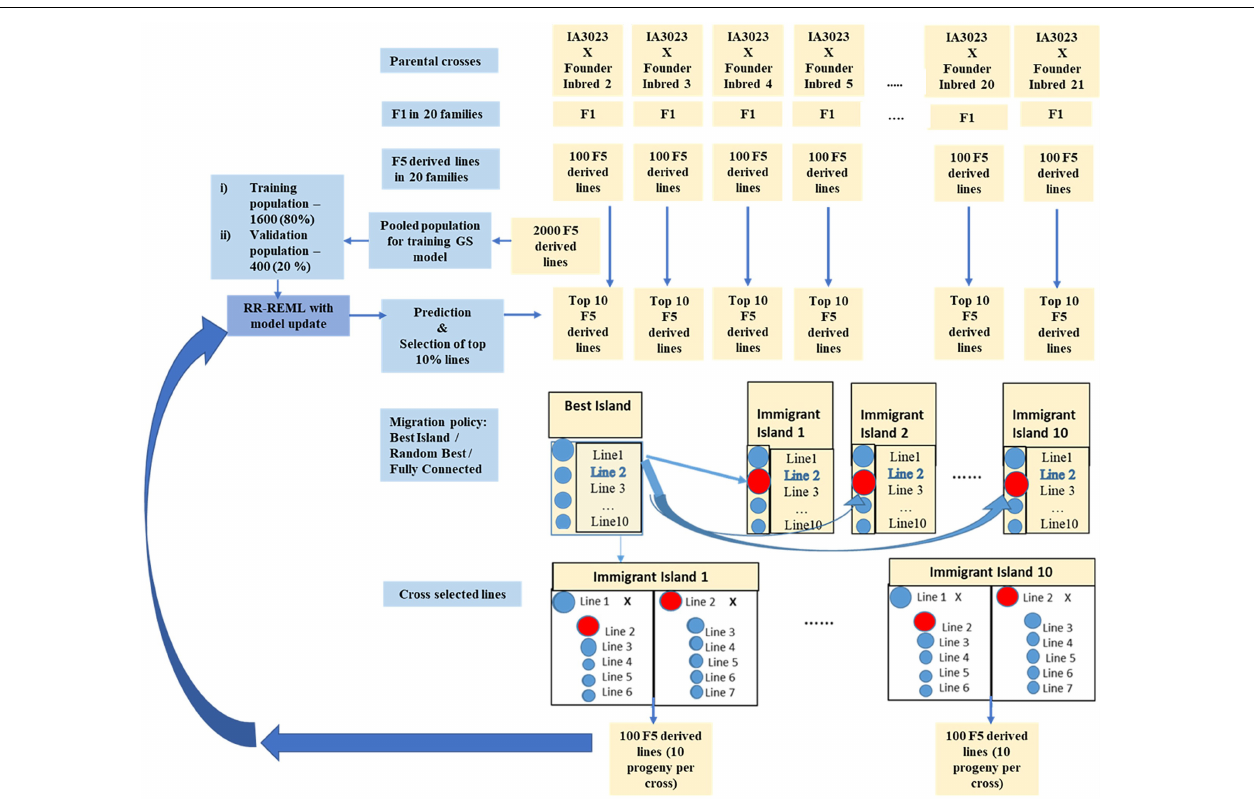
FIGURE 3 | Schematic representing simulated recurrent selection of family island populations where each of the 20 families from the founders is considered an island population. The schematic depicts the in silico steps used to generate the base population of 2000 F 5 derived lines derived from 20 founder lines crossed to IA3023; 100 F 5 -derived lines generated from each of the crosses form a distinct island. The depiction includes the model training step and the recurrent steps of prediction, sorting, truncation selection within islands, migration, crossing, and generation of 100 F 5 -derived lines per island for each cycle as well as the decision steps to check if the training set should be updated and if the recurrent process should be continued for another cycle. The blue shaded circles represent lines that are descendants of the founder populations in the islands and red shaded circles represent lines that are replaced by immigrants from the island with the largest genotypic value for the “Best Island”